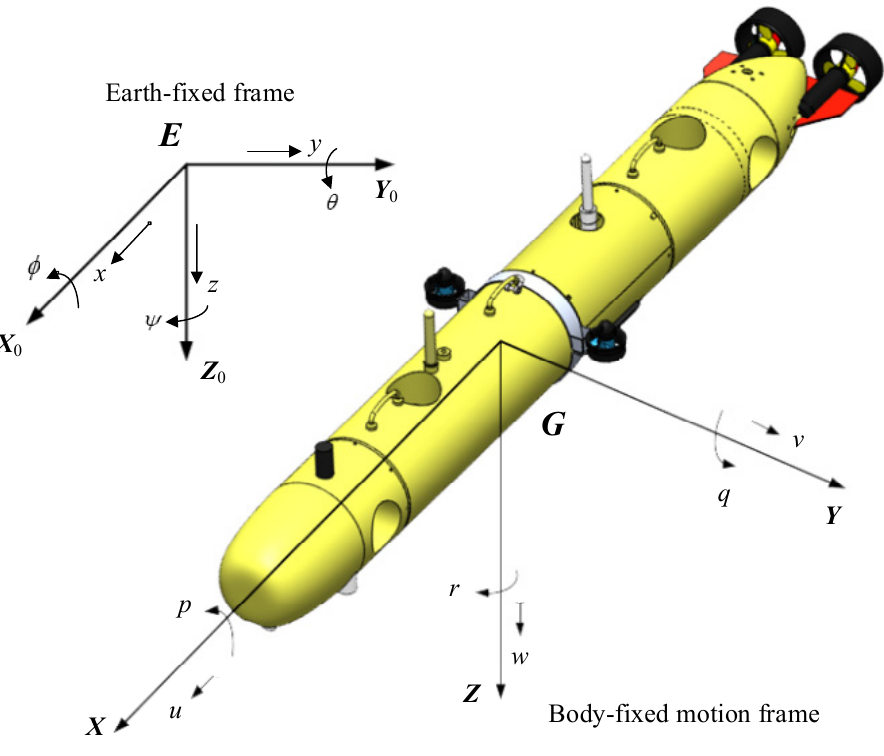
Figure 1. Body-fixed motion frame (G-XYZ) and earth-fixed frame (E-X0Y0Z0) for an AUV.